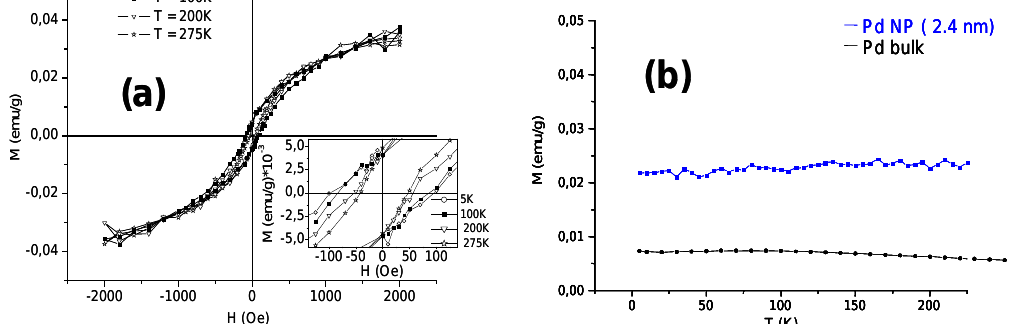
FIGURE 18. (a) Hysteresis loops of 2.4-nm Pd NPs; (b) thermal dependence of the magnetization (data from bulk Pd are also shown for comparison). From ref. [9].